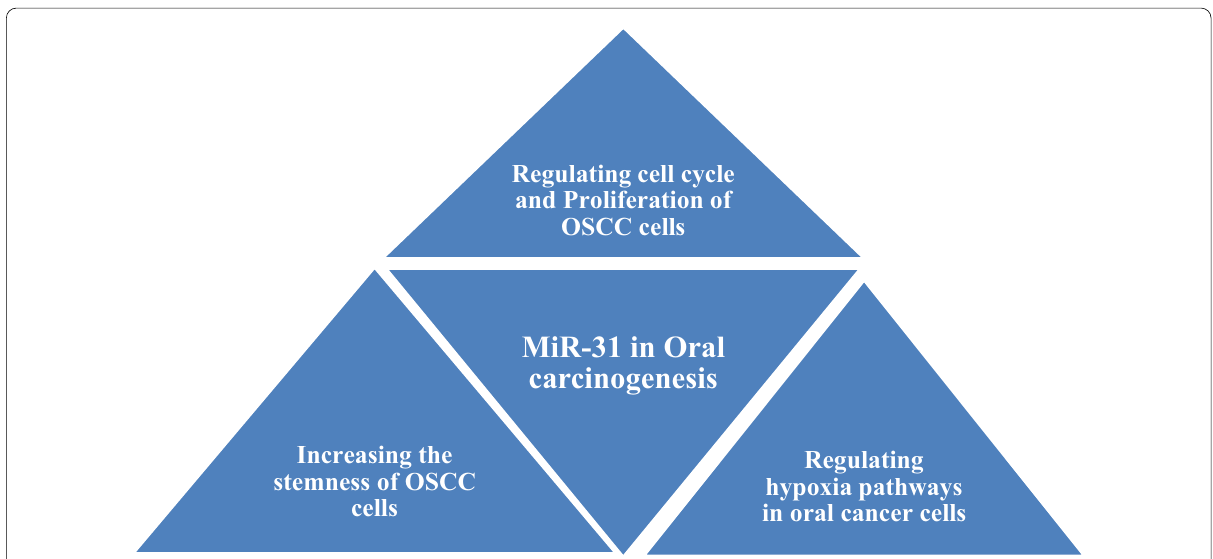
Fig. 1 Role of miR-31 in oral carcinogenesis. The figure depicts the various avenues in which miR 31 can affect oral